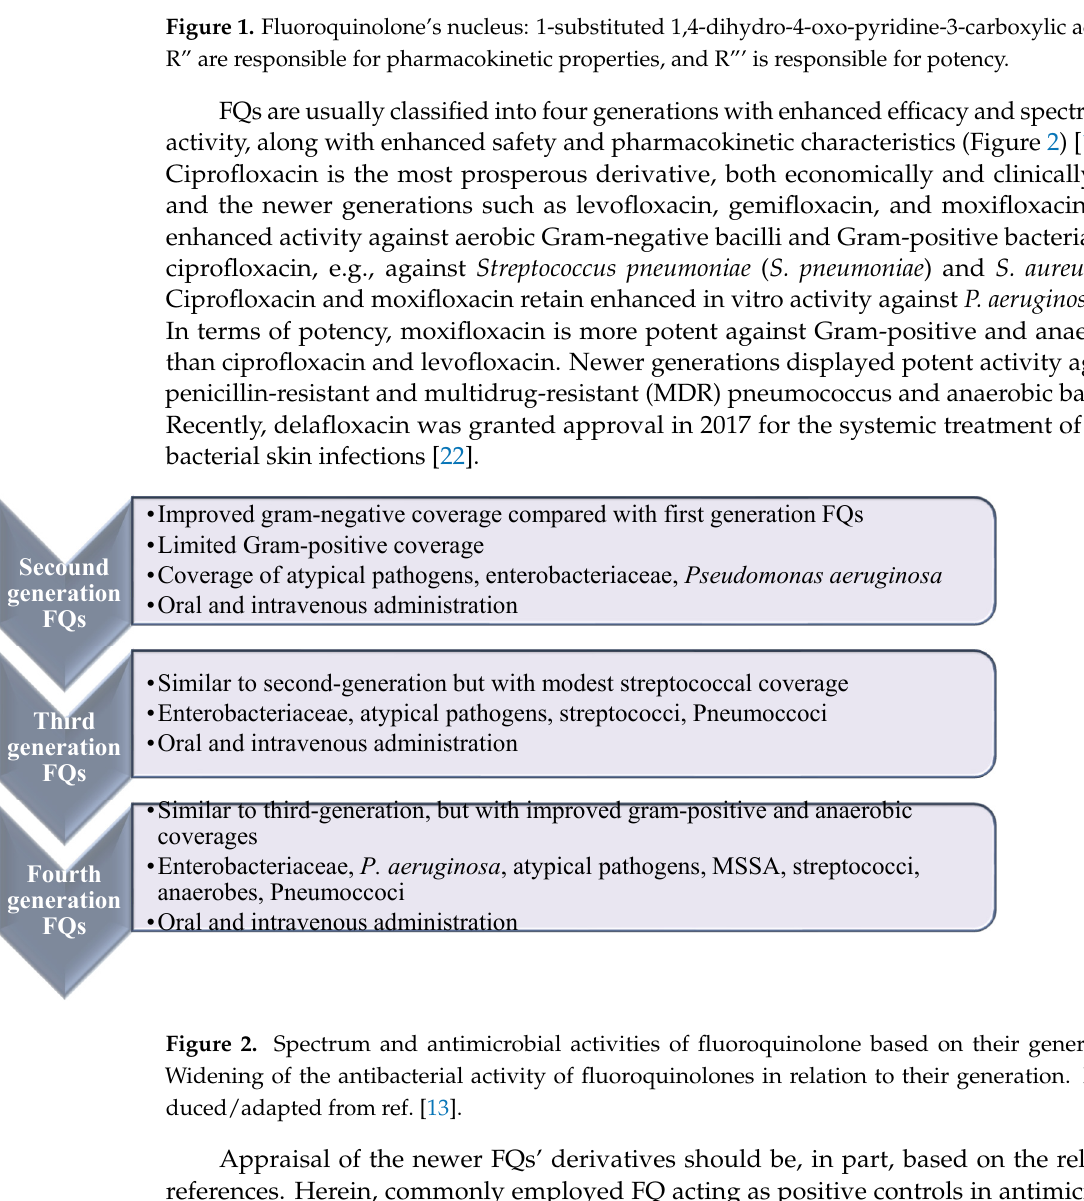
Figure 2. Spectrum and antimicrobial activities of fluoroquinolone based on their generations. Wid- ening of the antibacterial activity of fluoroquinolones in relation to their generation. Repro- duced/adapted from ref. [13] .